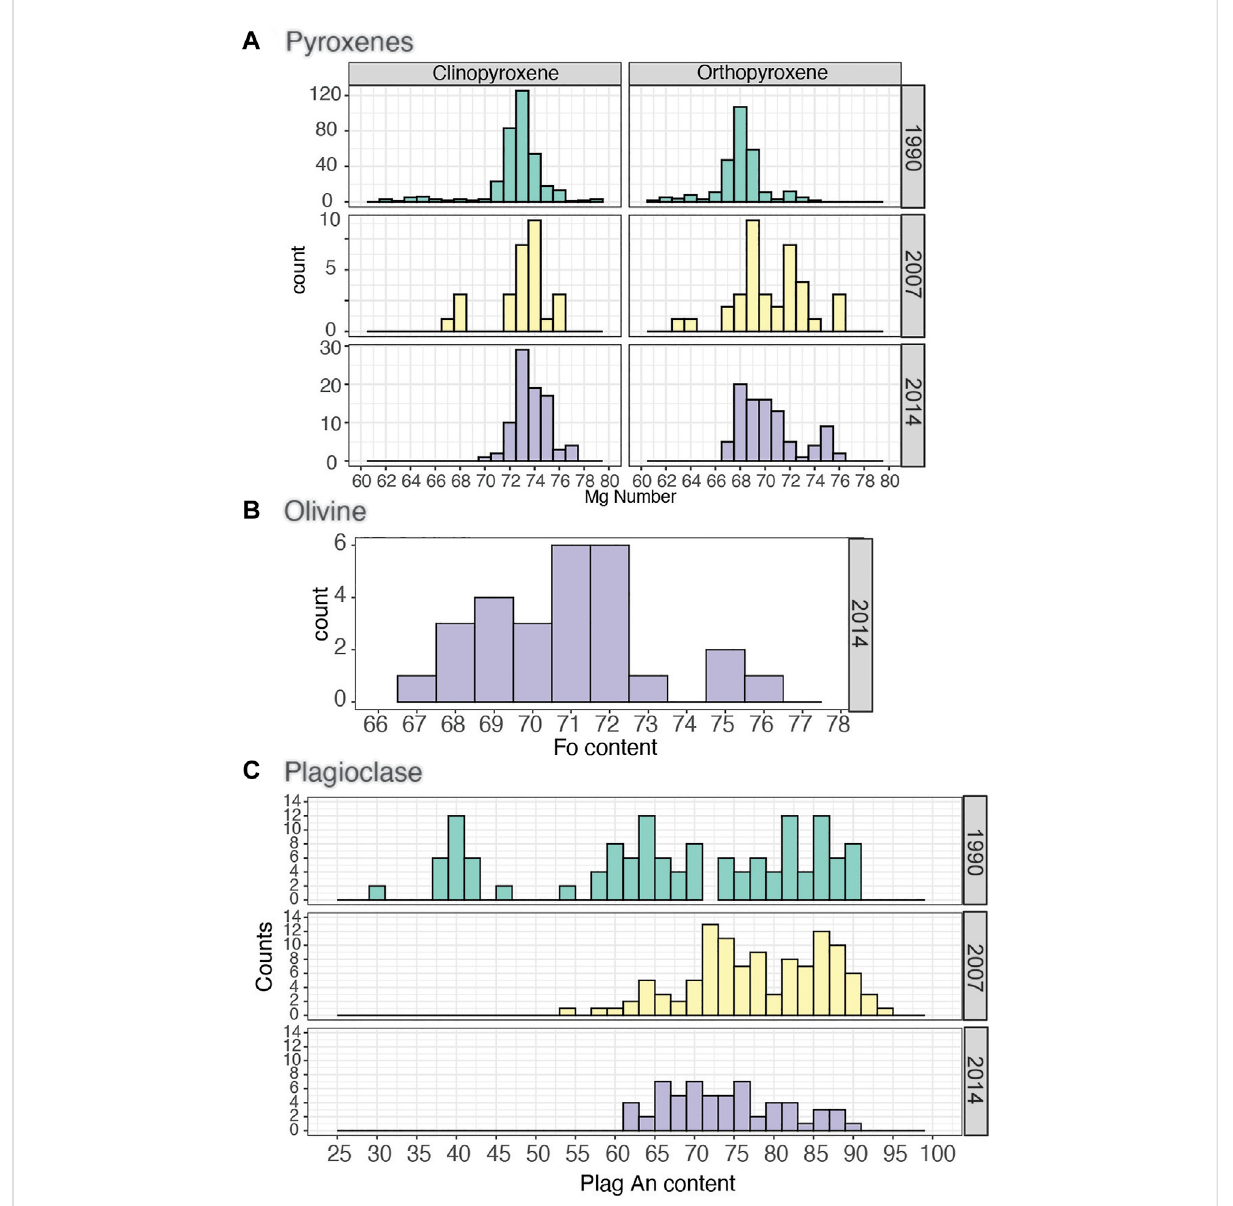
FIGURE 1 Histograms of representative mineral compositions from the 1990 – 2014 eruptions (A) pyroxenes, (B) olivine, and (C) plagioclase. Plagioclase compositionfromthe2014eruptioncomesfromacombinationofthisstudyandCassidyetal.(2016) andthoseofthe1990fromUtamietal.(2021).